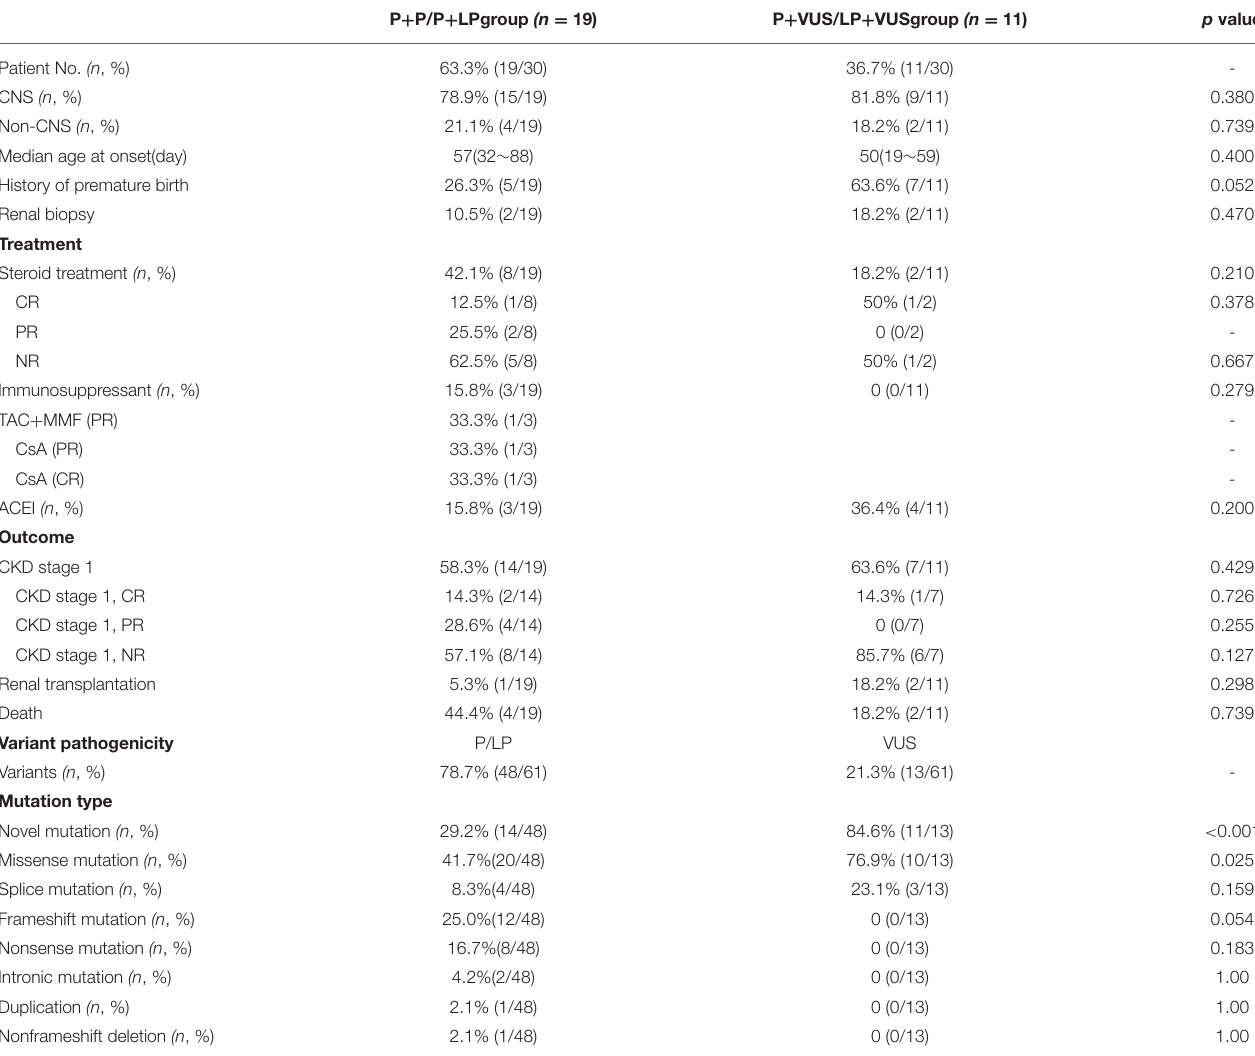
TABLE 4 | The comparison between two groups with different pathogenicity variants. P + P/P + LPgroup (n =